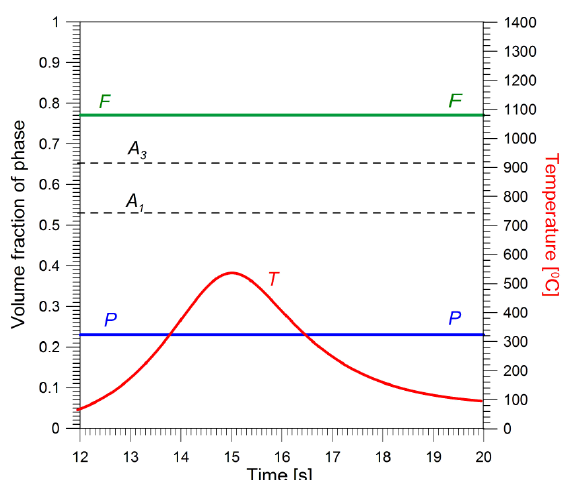
Figure 14. Thermal welding cycle and phase shares at point